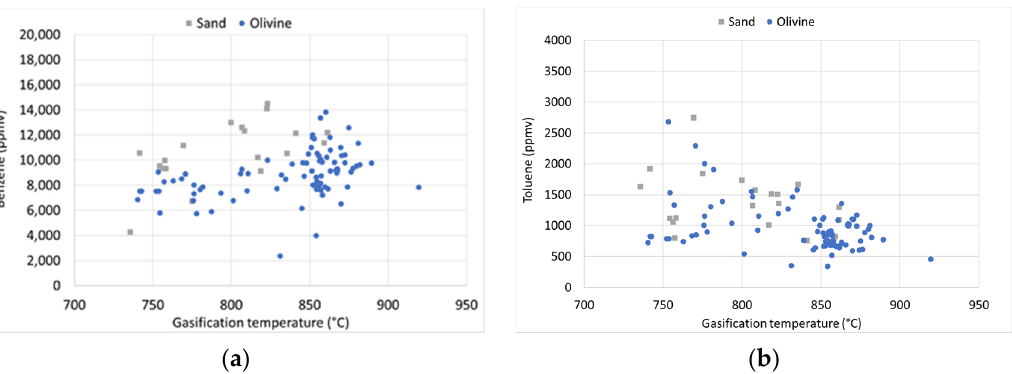
Figure 4. Concentrations in the product gas from atmospheric steam gasification in MILENA using sand and olivine: ( a ) benzene; ( b ) toluene.